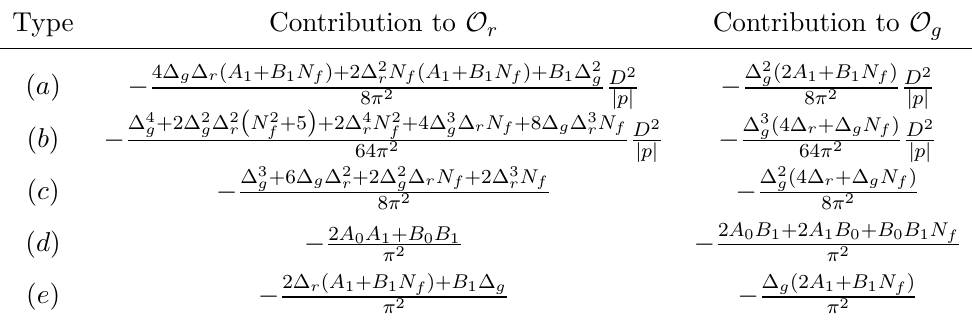
Table 4. The logarithmically diverging parts of the ( a )–( e ) diagrams for the case N